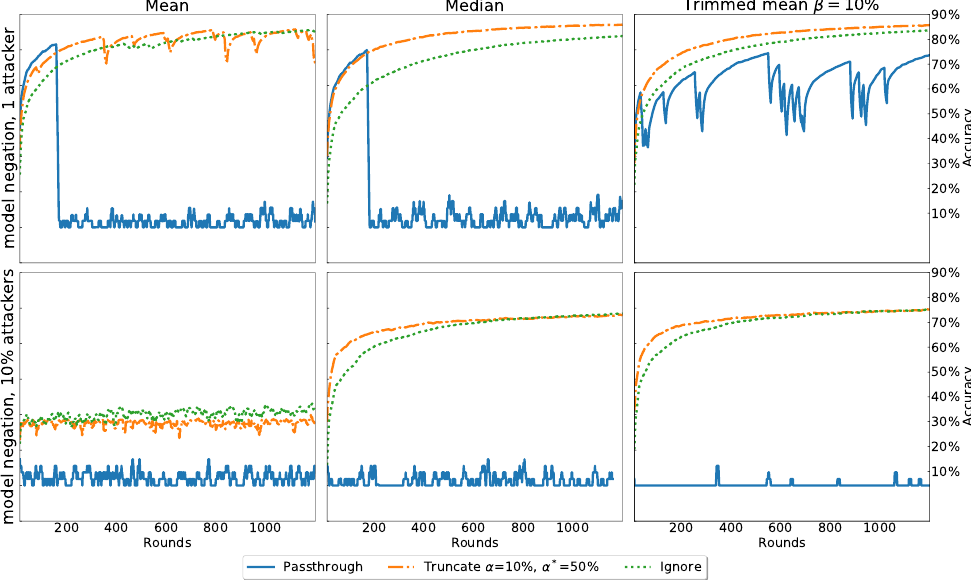
Figure 4. Accuracy by round under Byzantine attacks for the Shakespeare experiments. Curves correspond to preprocessing procedures, and columns correspond to different aggregation methods. In the two rows of the experiment, the Byzantine clients perform a model negation attack with 1 and 10% attackers,